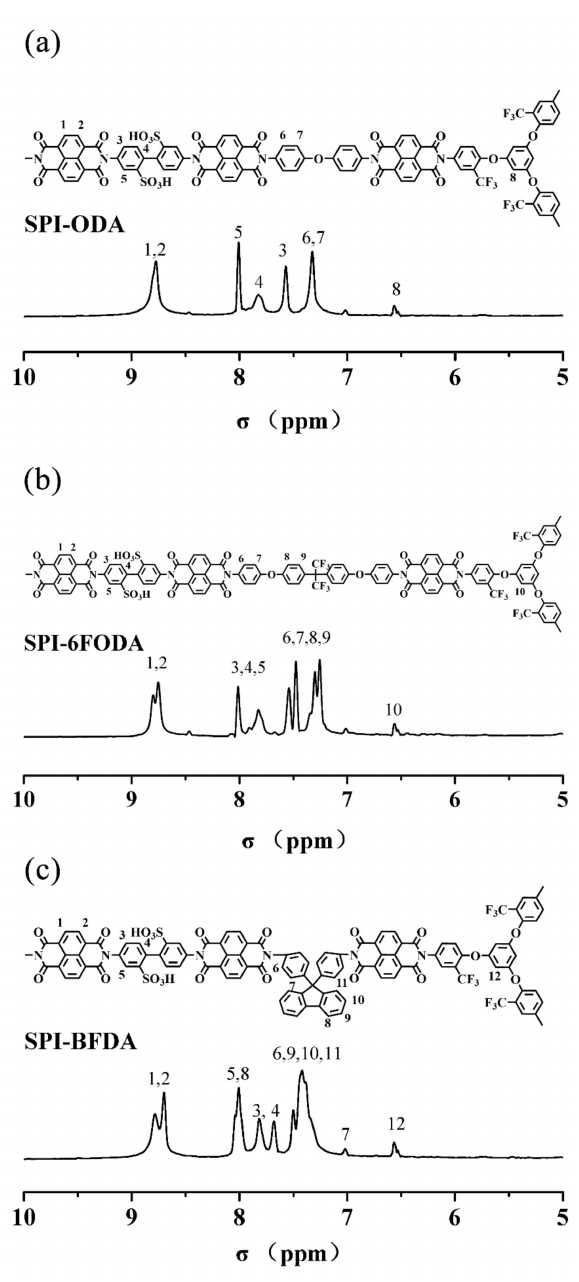
Figure 2. 1 H NMR spectra of the ( a ) SPI-4,4 (cid:48) -oxydianiline (ODA), ( b ) SPI-2,2-bis[4-(4-aminophenoxy) phenyl]hexafluoropropane (6FODA), and ( c ) SPI-4,4 (cid:48) -(9-fluorenylidene)dianiline